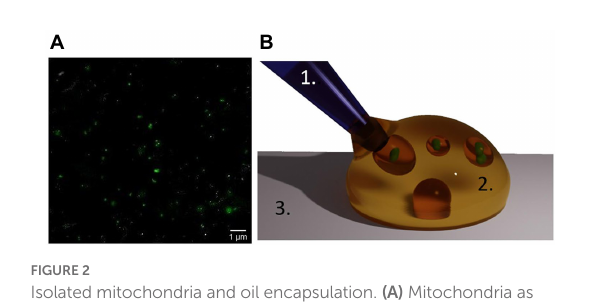
FIGURE 2 Isolated mitochondria and oil encapsulation. (A) Mitochondria as seen by optical fluorescent microscopy after SYBR green staining of the mt-DNA. (B) Suspension of mitochondria in water-in-oil droplets in our assay. A solution containing mitochondria (green) in their culture medium (plus the chemical which action on the organelles is under study), is manually injected using a micro-pipette (1) into an oil droplet (2) on a glass surface